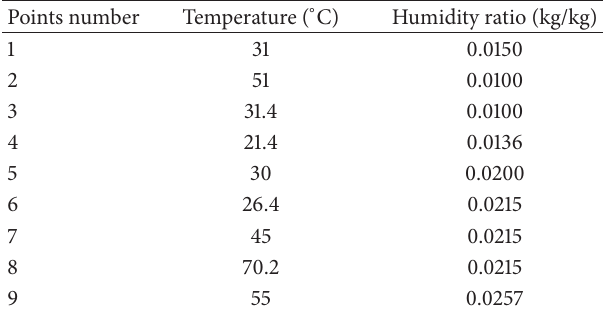
Table 3: Air properties of one-stage solar desiccant cooling system in recirculation